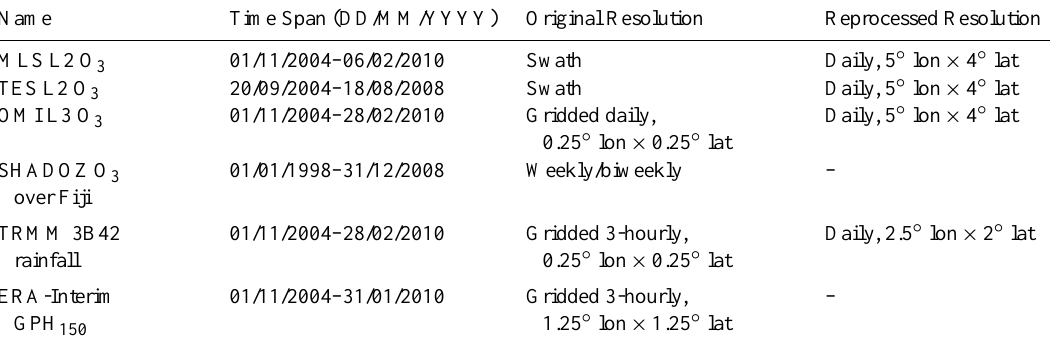
Table 1. Datasets used in this work. MLS Level-2 (L2) v2.2 O 3 and TES L2 O 3 are swaths products. They have been regridded into 5 ◦ -longitude × 4 ◦ -latitude daily products in this work. OMI Level-3 (L3) O 3 and TRMM 3B42 rainfall has also been regridded into 5 ◦ - longitude × 4 ◦ -latitude and 2.5 ◦ -longitude × 2 ◦ -latitude daily products, respectively, in this work (see text). Fiji is located at (178.40 ◦ E, 18.13 ◦